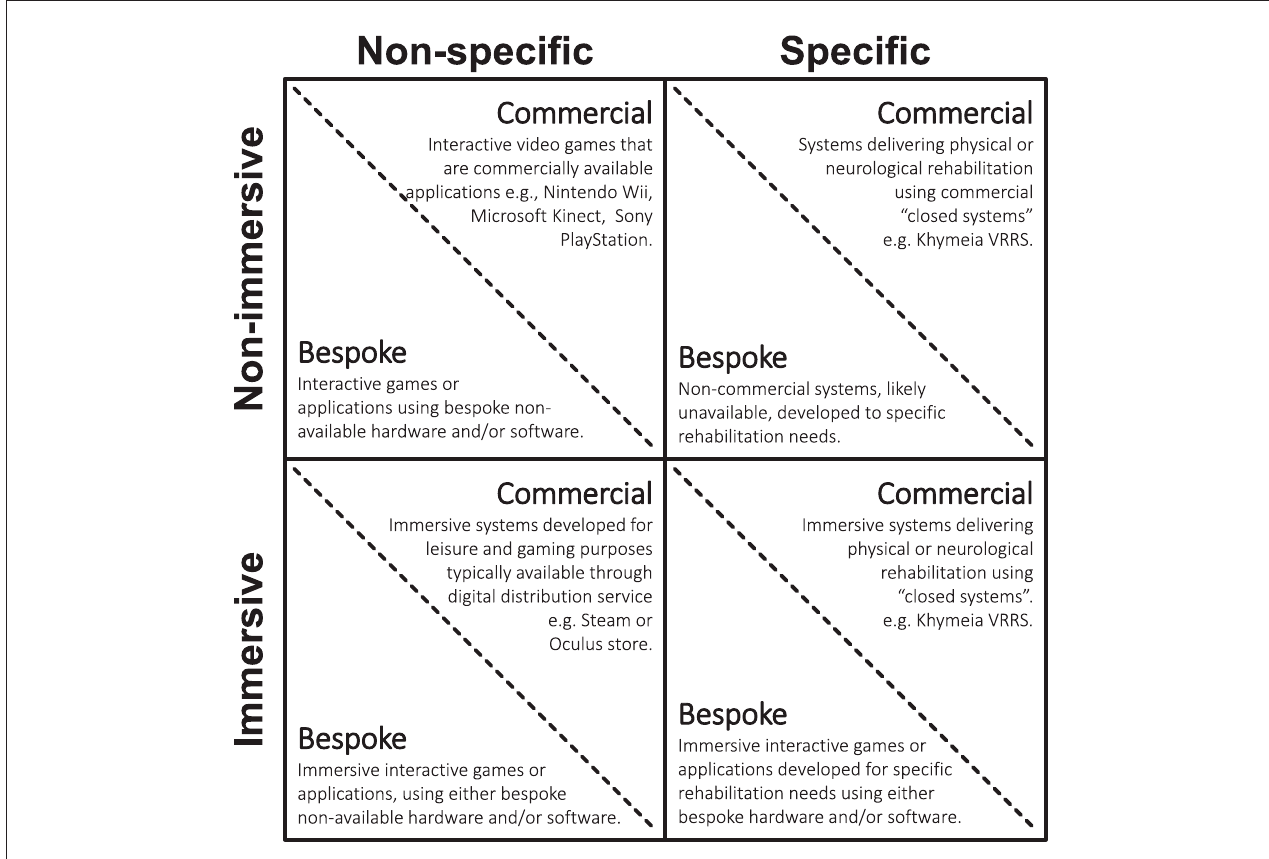
FIGURE 9 | Taxonomy of virtual rehabilitation